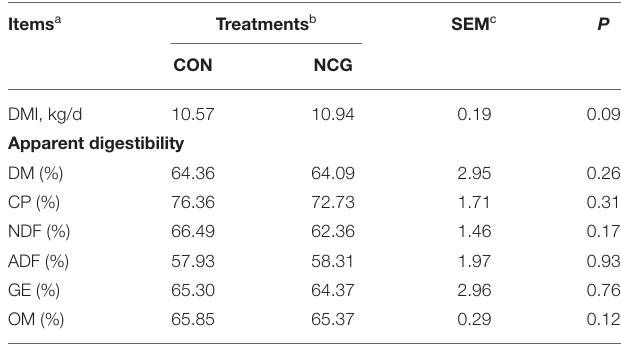
TABLE 2 | Effect of NCG on nutrients digestibility.